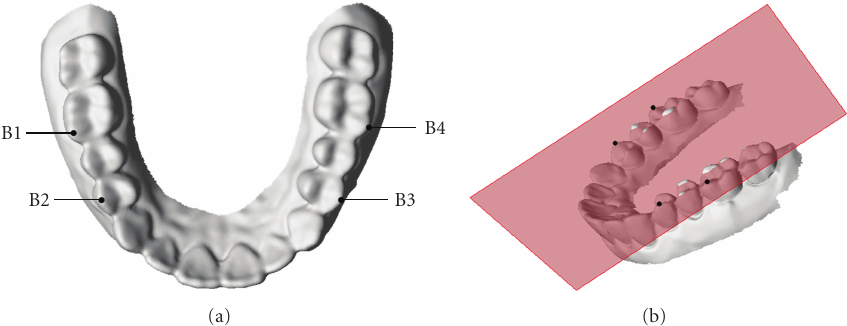
Figure 9: (a) B1, B2, B3, and B4 are the corresponding reference points. (b) The occlusal plane fitted to the four reference points.